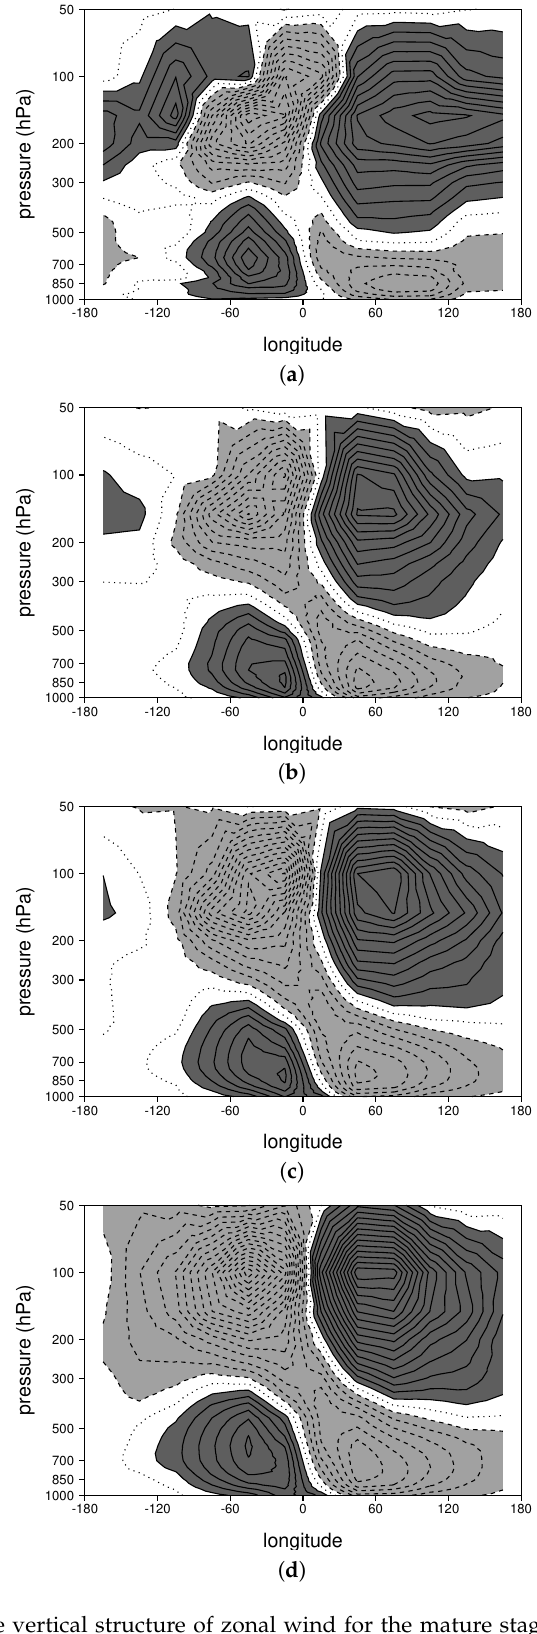
Figure 2. Composite vertical structure of zonal wind for the mature stage of the MJO for: ( a ) the observed MJO; ( b ) the control run; ( c ) the 3 K warming experiment; and ( d ) the 7 K warming experiment. The contour interval is 0.5 m/s, and values greater (less) than 0.5 ( − 0.5) m/s are shaded dark (light)